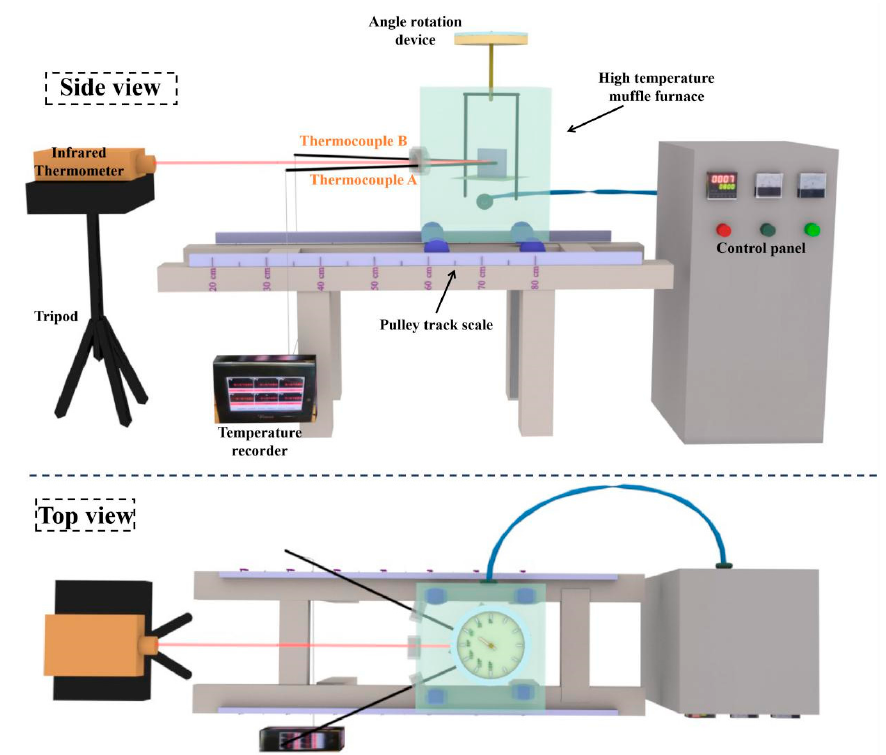
Figure 2. Schematic diagram of determination of emissivity. Table 4. Evolution of emissivity of the 8YSZ ceramic coating with temperature.